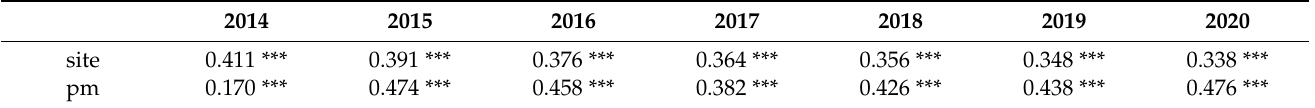
Table 2. Statistical tests of spatial autocorrelation by Moran’s I.